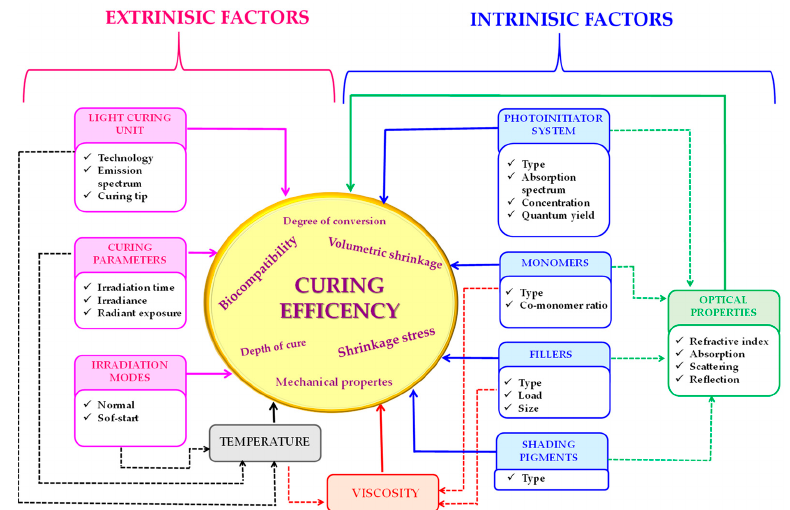
Figure 1. Illustrative diagram showing the influence of factors on the quality of obtained dental Figure1. composites.